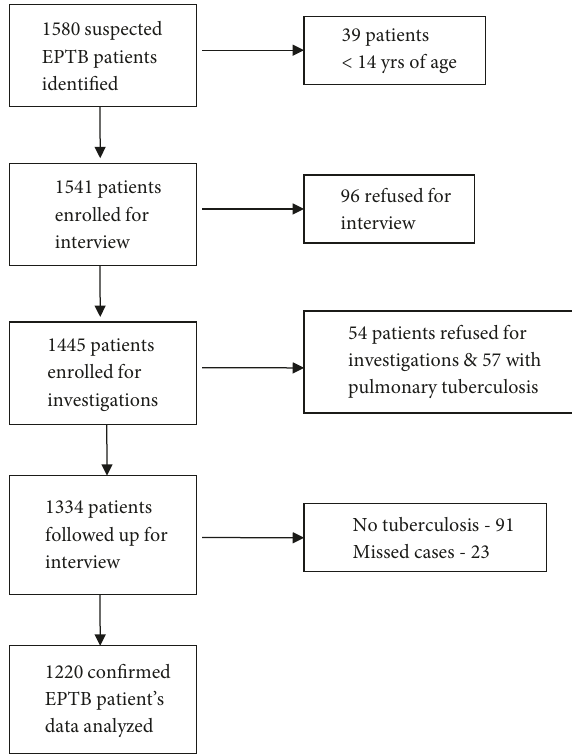
Figure 1: An overview of the patients enrolled in the